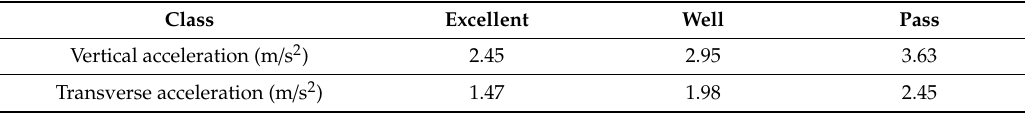
Table 5. Evaluation standards for the vibration acceleration of a train body.